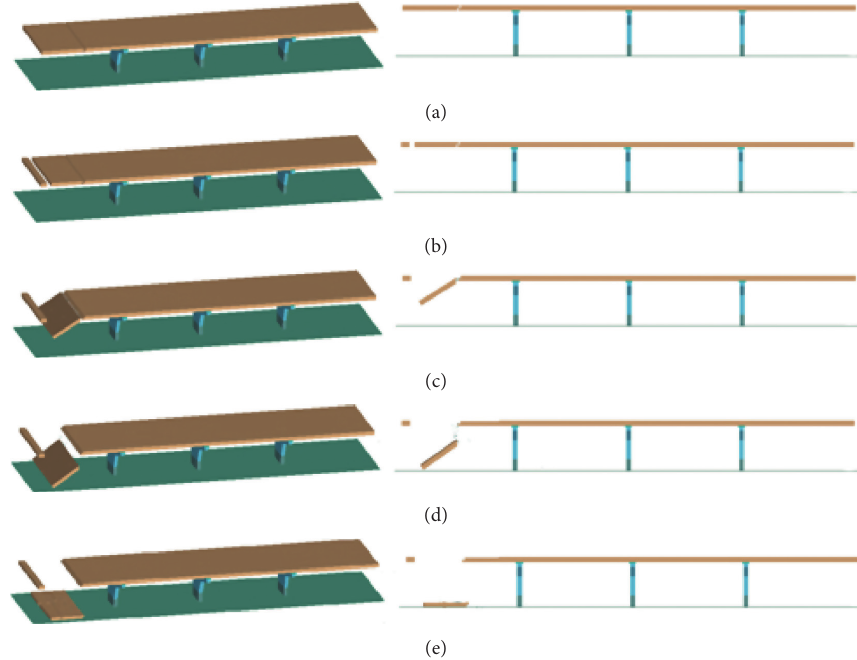
Figure 18: Collapse response of Hongqi Bridge in the case of one hinge in the first span: (a) t � 0.00 s, (b) t � 0.10s, (c) t � 0.90s, (d) t � 1.46s, and (e) t �